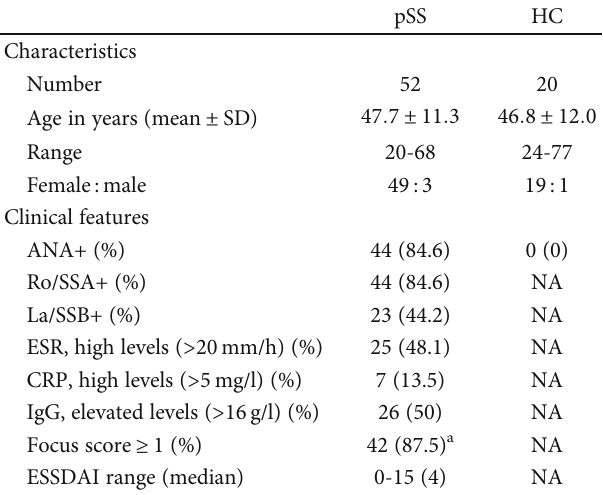
Table 1: Overview of individuals at baseline used in this